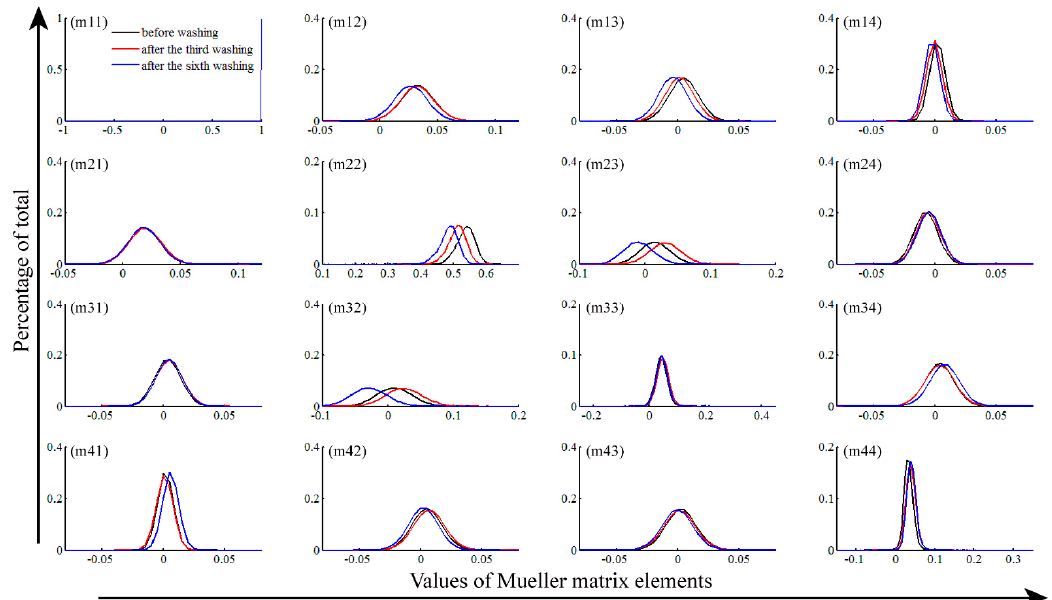
Figure 3. Frequency distribution histograms (FDHs) of Mueller matrix elements of silk sample washed by the fabric softener: before washing (black lines), after the third washing time (red lines) and the sixth washing time (blue lines). The areas under the FDH curves are normalized to 1, and the horizontal axis is divided into 400 parts.